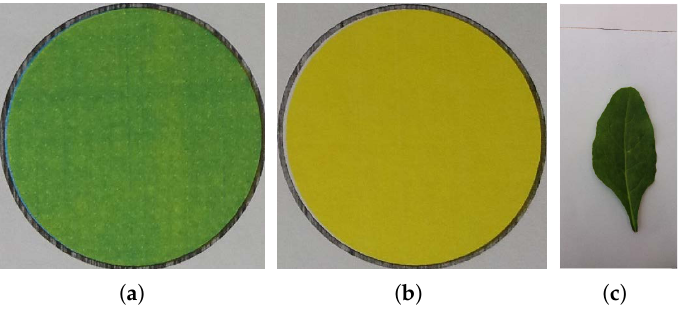
Figure 3. The extracted regions of interest in Figure 2b: ( a ) I g , ( b ) I y , ( c ) I l